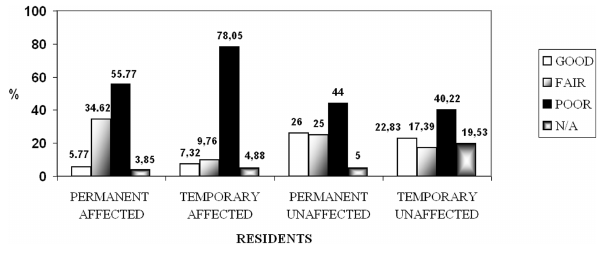
Fig. 6. Assessment of flood management practices. Residents.